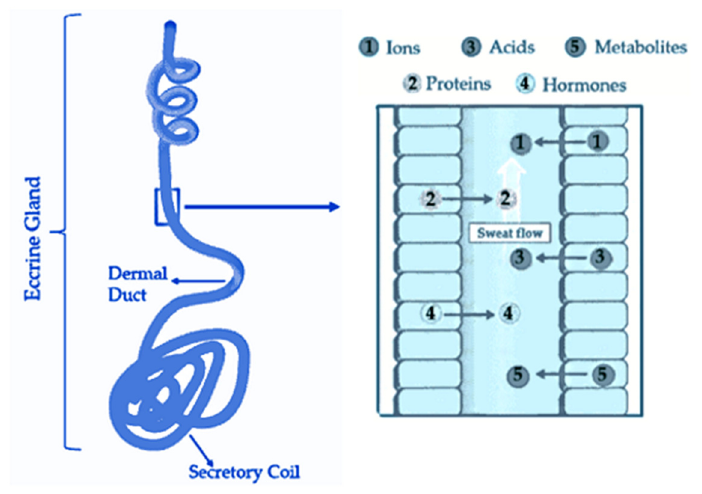
Figure 1. Eccrine sweat gland structure and biomarker partitioning [43].